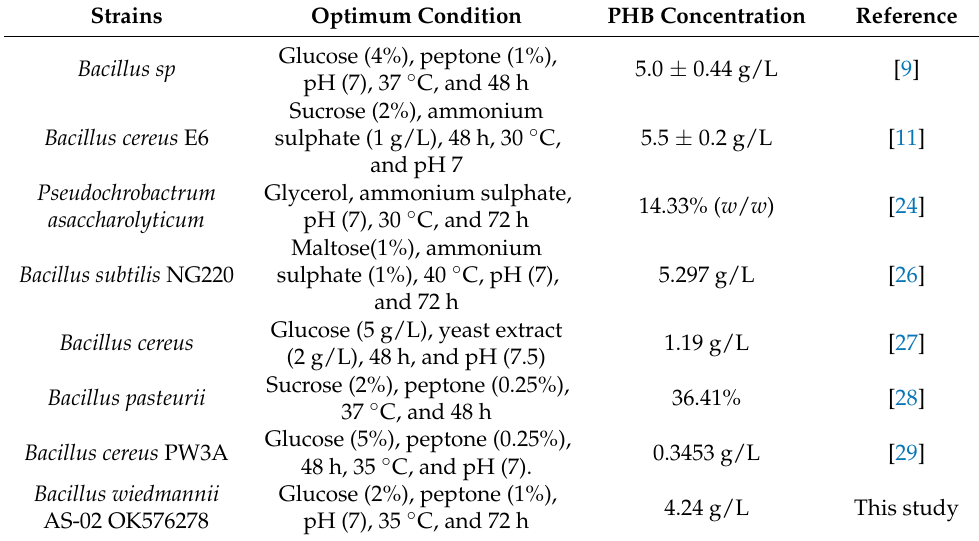
Table 4. Comparison of PHB production by different bacteria under optimum